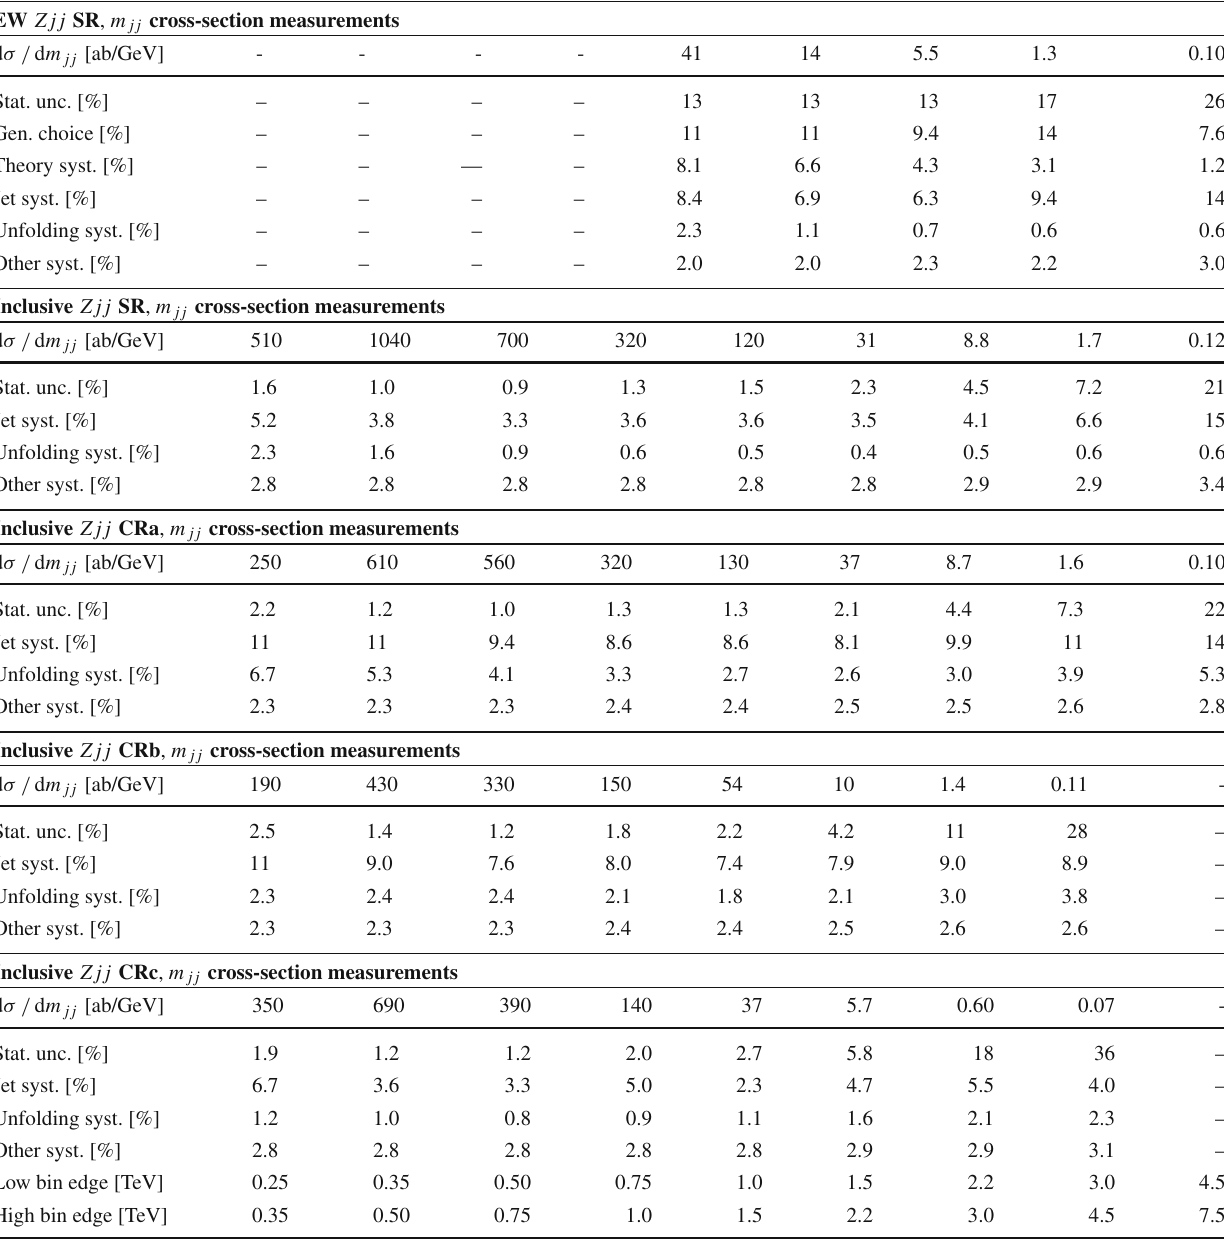
Table 5 Differential cross-section measurements for EW Zjj production and inclusive Zjj production as a function of m jj . The EW Zjj measurements are performed in the signal region. The inclusive Zjj measurements are performed in the signal region and three control regions. The different sources of uncertainty are grouped together for each measurement, with a more granular breakdown of each uncertainty available in HEPDATA EW Zjj SR , m jj cross-section